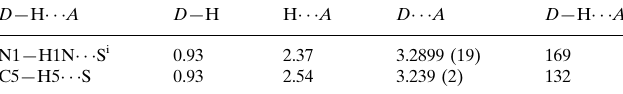
Hydrogen-bond geometry (A˚ , (cid:1)